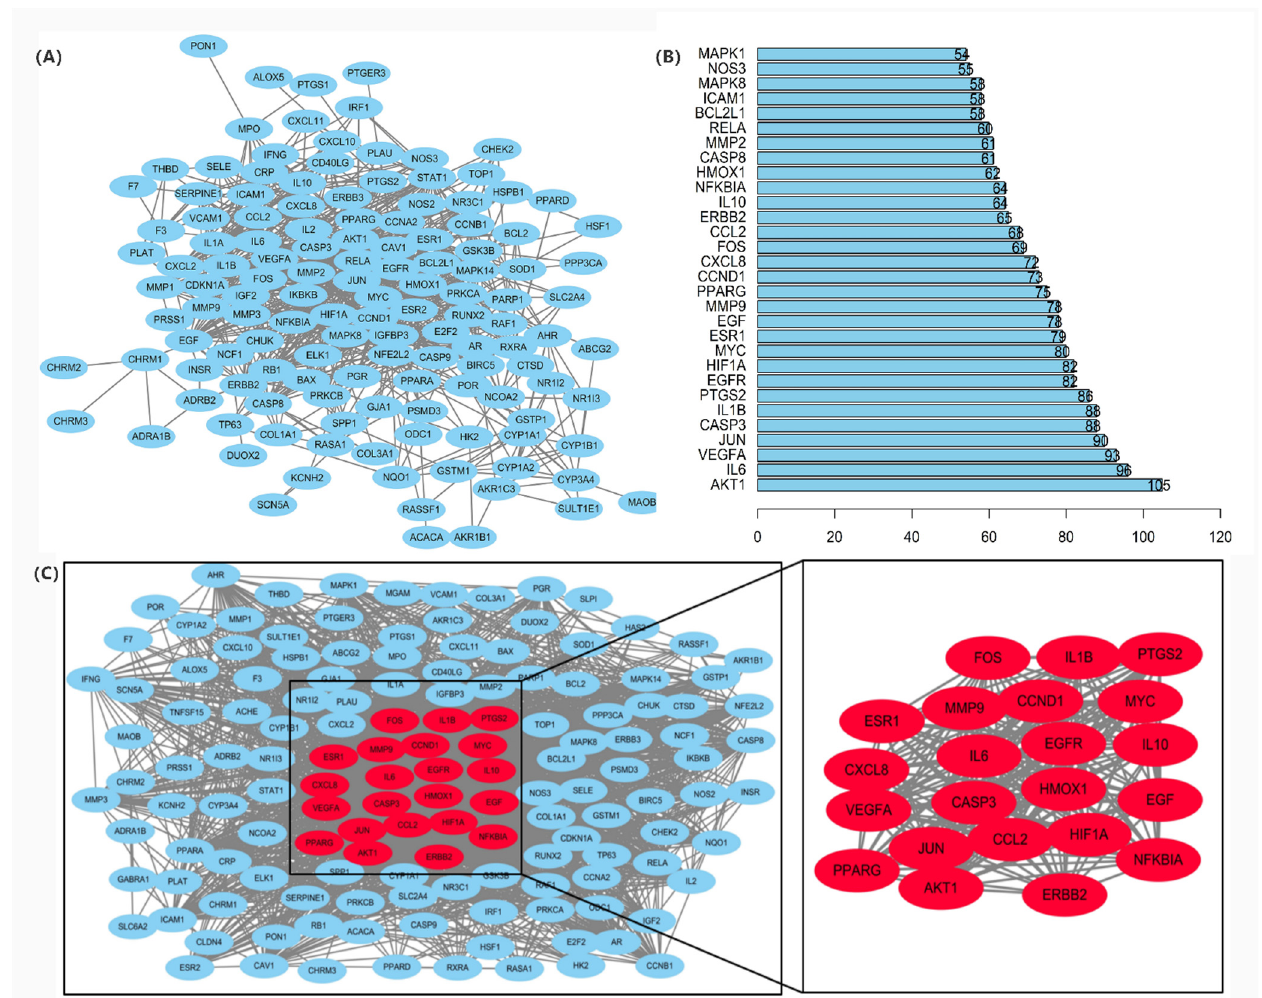
Figure 3. ( A ) PPI protein interaction network. Note: Network nodes represent proteins. Each node represents all proteins produced by a single protein-coding locus; the edge represents the protein- protein binding and promotes sharing function. ( B ) PPI network core genes. ( C ) Key targets of PPI network in the treatment of autoimmune hepatitis.